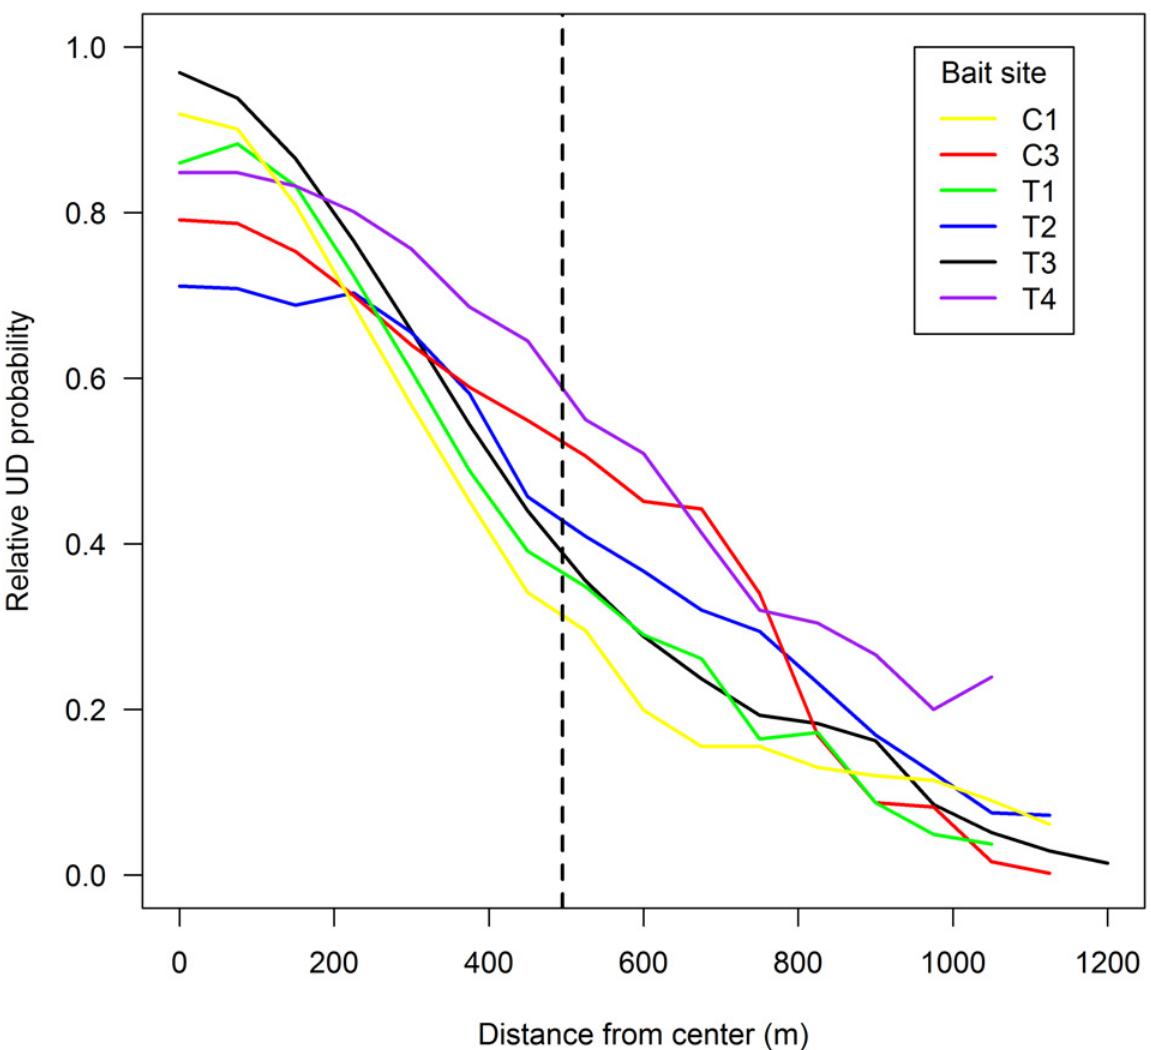
Figure 4. Decay in the relative probability of rabies placebo bait consumption as a function of distance from the center of the bait distribution area. The dashed line represents the approximate edge of the bait zone across the six sites. Two sites were excluded due to low sample